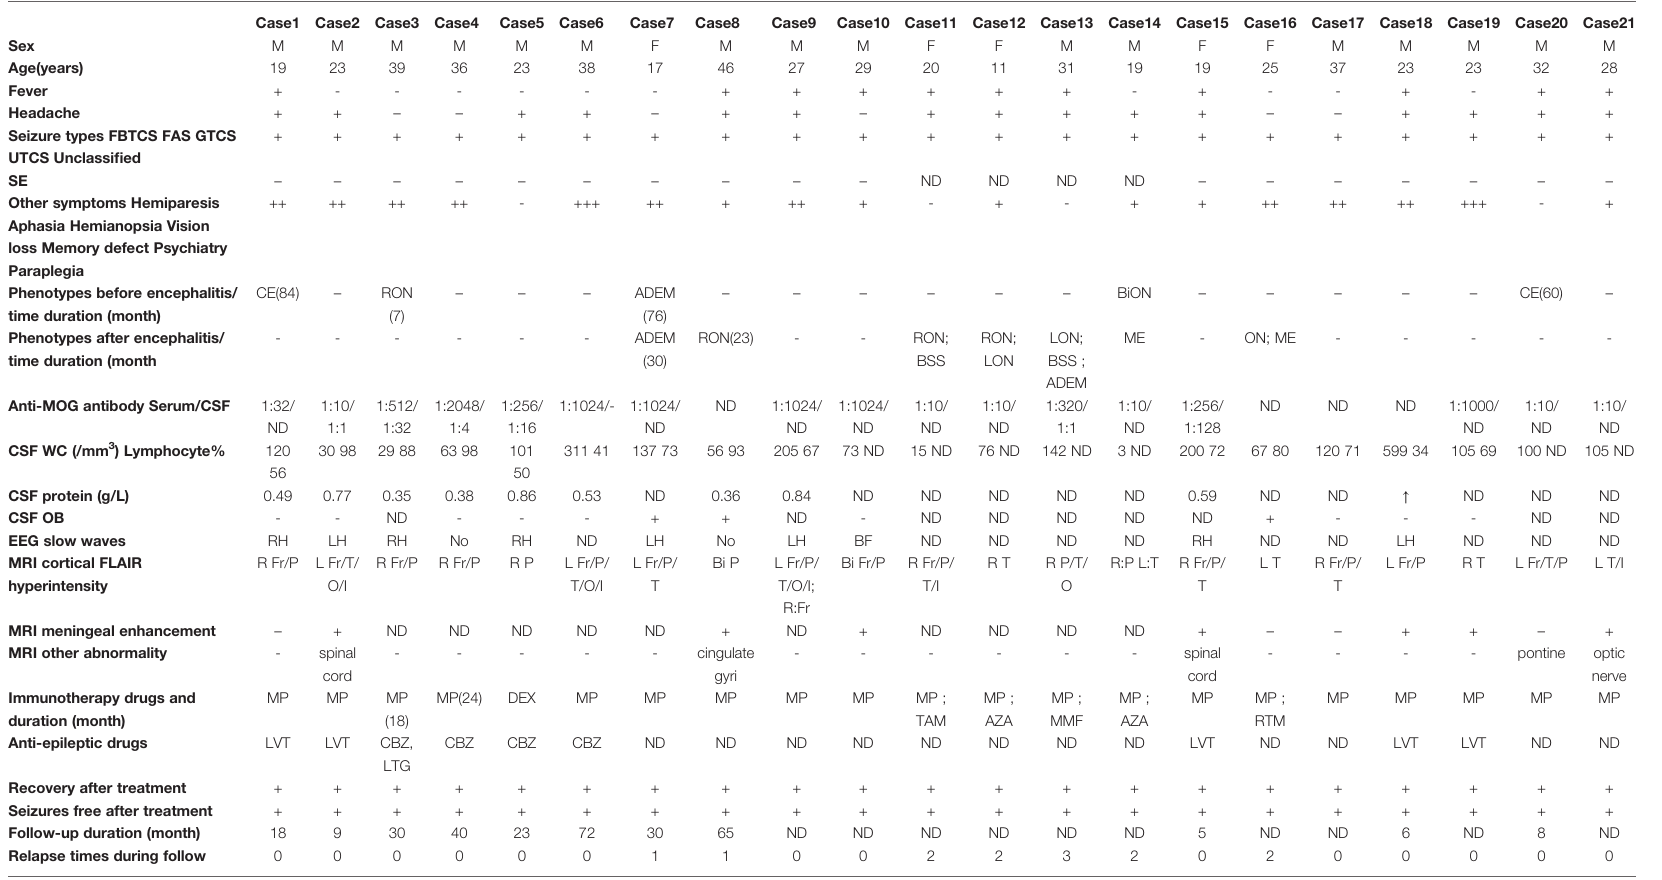
TABLE 1 | The clinical manifestations, diagnostic examination and outcome of FLAMCES.